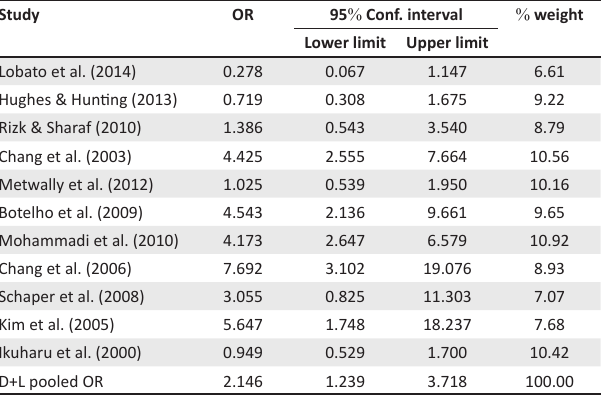
FIGURE 2: Noise plus solvent versus noise only. TABLE 2: Noise plus solvent versus noise